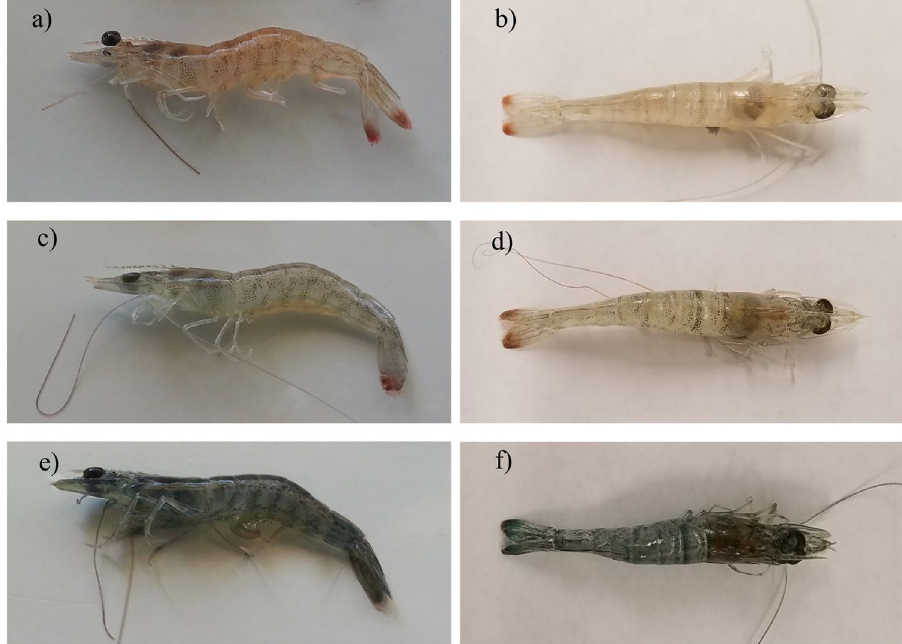
Figure 4. Body color of juvenile shrimp exposed to different concentrations of fipronil. Controls ( a , b ), 0.1 µ g/L treatment ( c , d ), 1.0 µ g/L treatment ( e , f